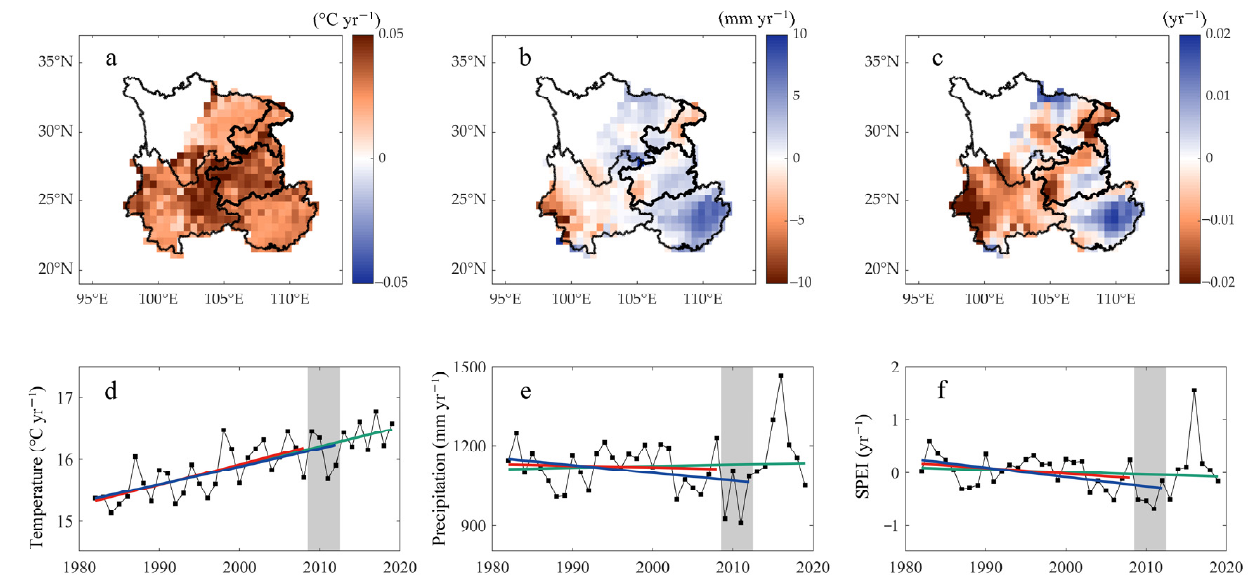
Figure 5. Climate change, dry and wet changes in SWC from 1982 to 2019. ( a , d ) show temperature change, ( b , e ) show precipitation change, ( c , f ) show SPEI change. Red is the change trend before drought (BDT), blue is the change trend after drought (ADT), and green is the long-term trend (LTT).